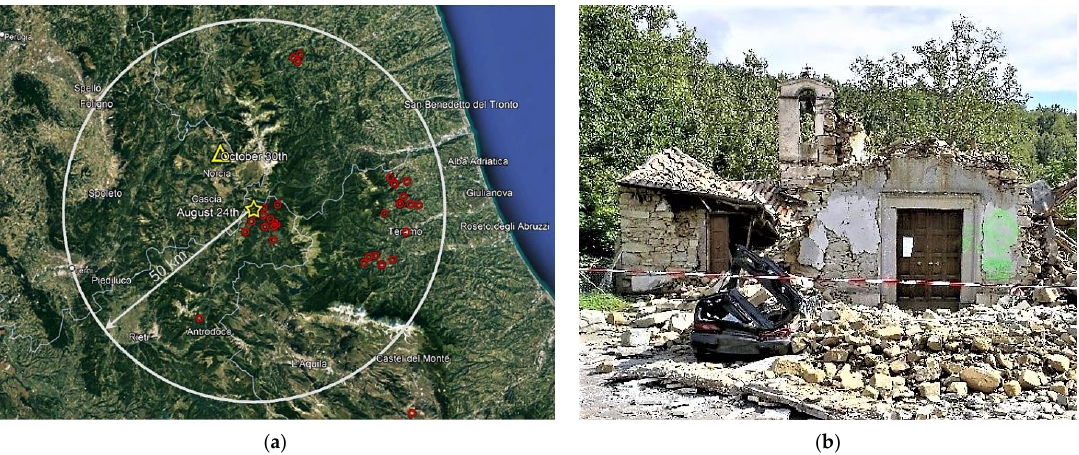
Figure 1. ( a ) Geographical localization (adapted from Google Earth) of the inspected churches (red circles), with the position of epicenters of 24 August (yellow star) and 30 October 2016 (yellow triangle); ( b ) a disrupted church in Amatrice, 5 km away from the epicenter of 24 August.